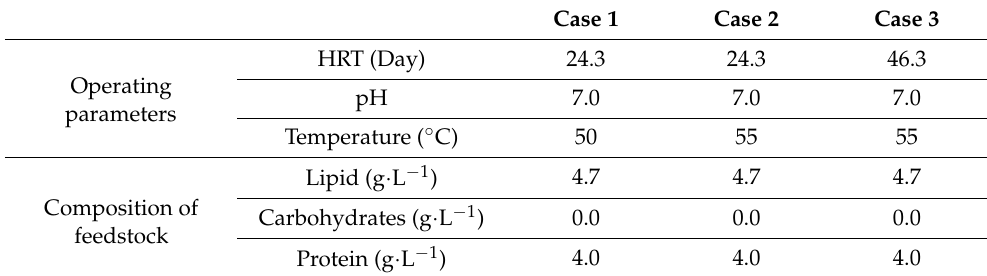
Figure 4. Efficiency of different cases studied. Table 4. Input values for case